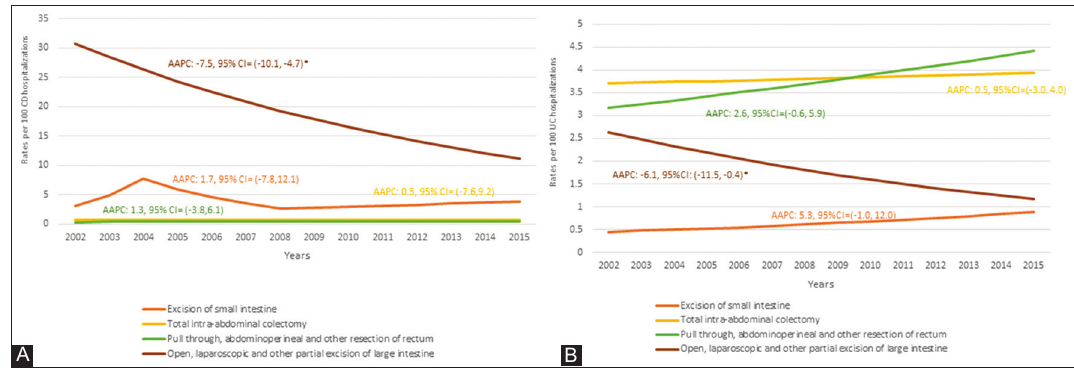
Supplemental Figure 3: Rates of surgeries per 100 Crohn’s disease [CD] (A) and ulcerative colitis [UC] (B) hospitalizations over the years 2002-2015 AAPC= Average Annual Percent Change. *p≤0.05